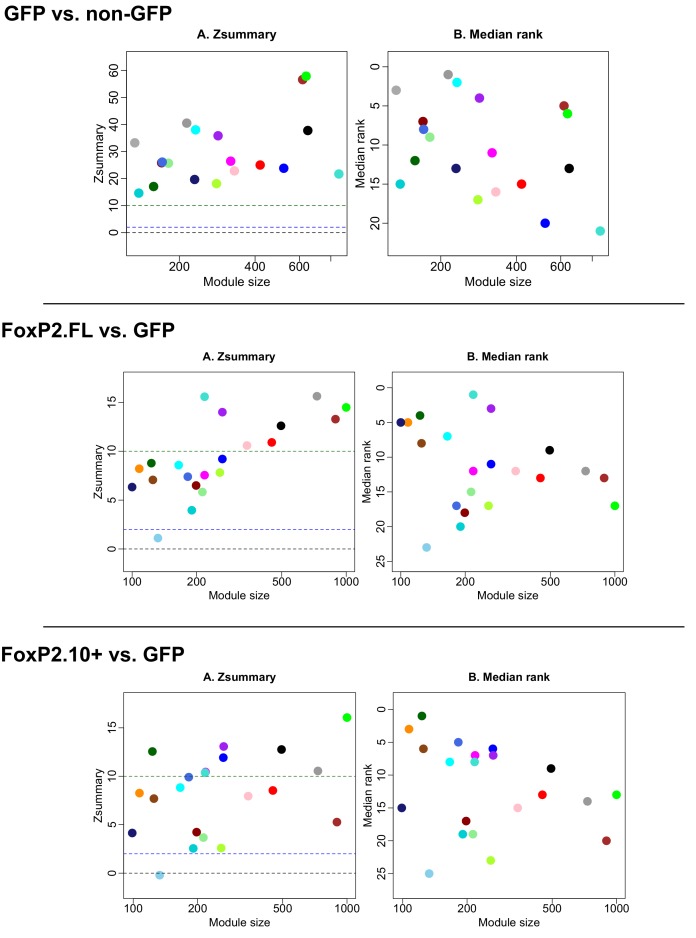
Module preservation between GFP vs FoxP2.FL and FoxP2.10+ combined, GFP vs. FoxP2-FL, and GFP vs. FoxP2.10+ networks. Plots depict module preservation vs. module size for each virus construct pair and allow for visual assessment of whether a specific module exists in two conditions. Middle and upper dashed horizontal lines indicate thresholds for low and high preservation, respectively.